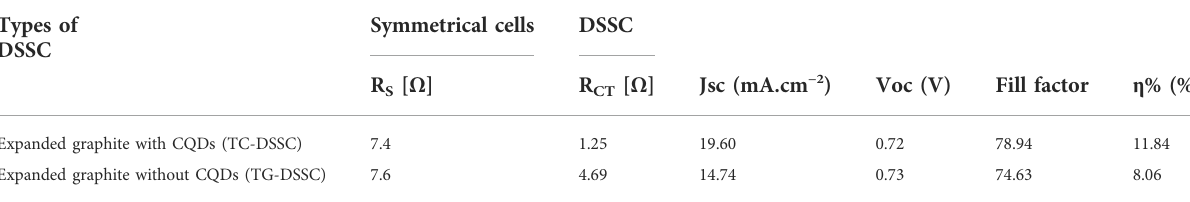
TABLE 1 Comparison of electrochemical and photovoltaic performance of cells fabricated by expanded graphite nonwoven with CQDs and without CQDs electrodes. Types of